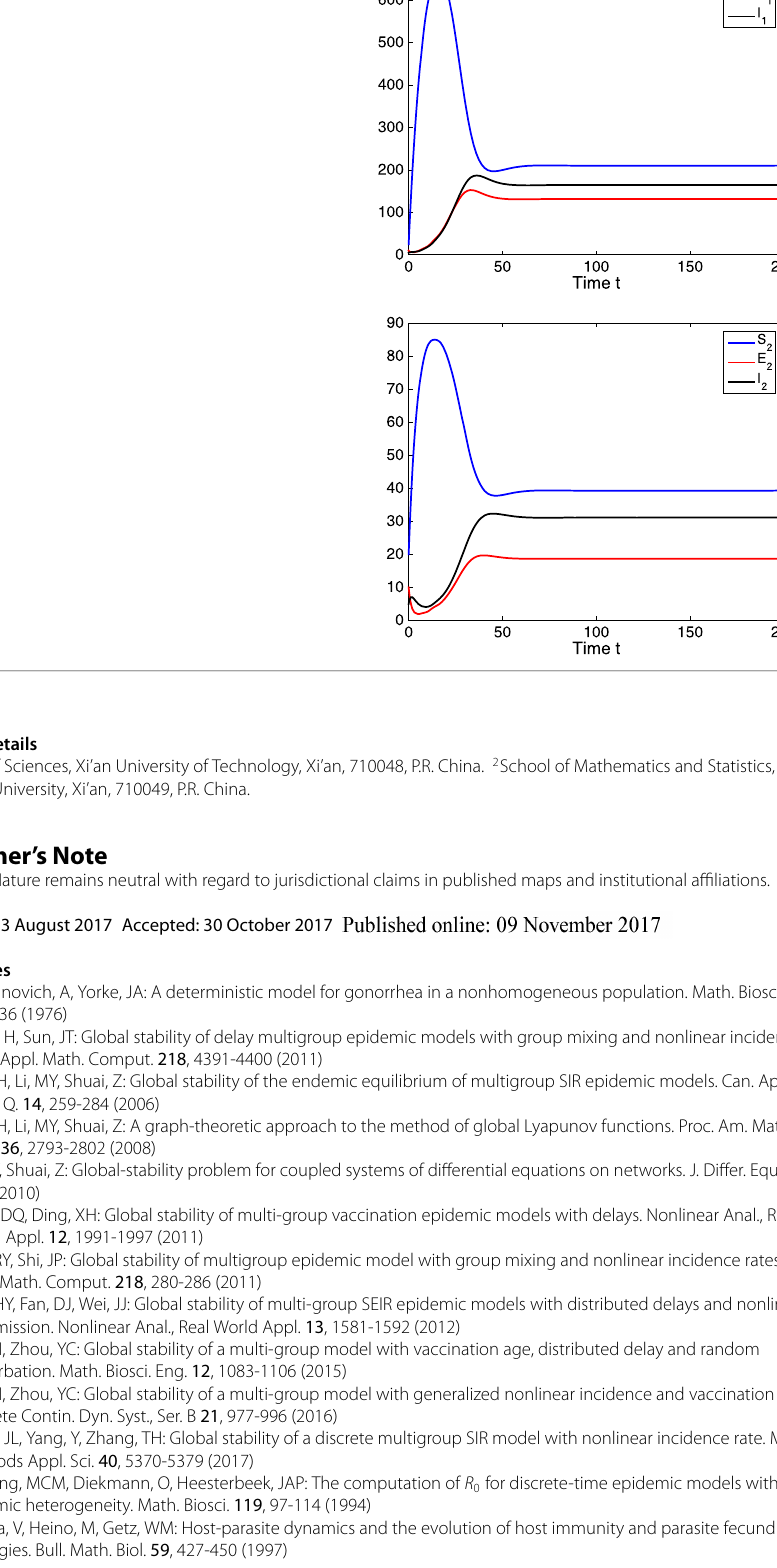
Figure 2 Solution for system (5) with R 0 = 4.4704 >